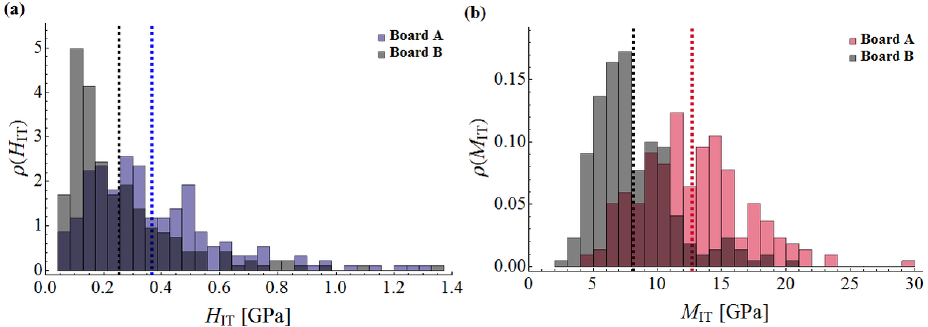
Figure 12. ( a ) Histograms of hardness; ( b ) histograms of indentation modulus. Table 2. Summary of nanoindentation results.